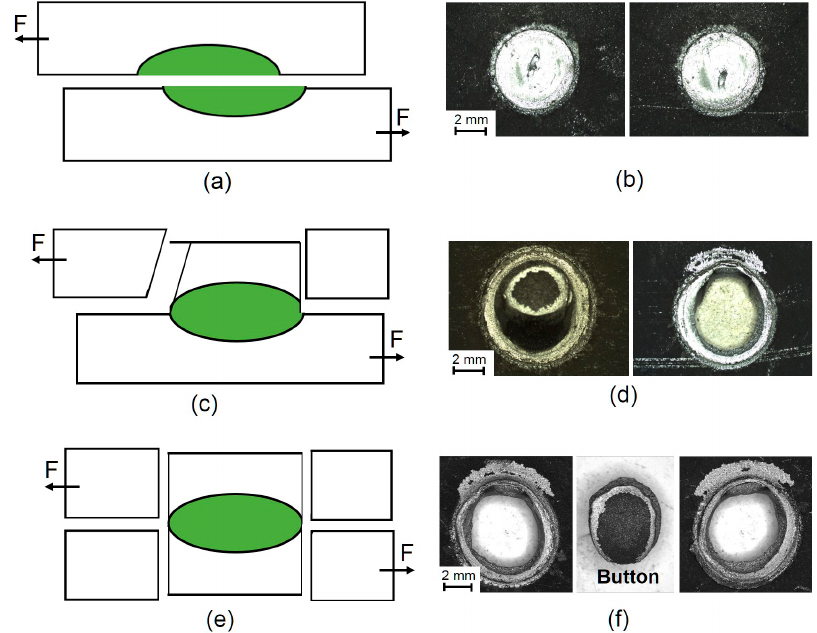
Figure 4. Typical fracture mode for welded B1500 joint: ( a ) schematic of IF; ( b ) failed IF joint; ( c ) schematic of PF I; ( d ) failed PF II joint; ( e ) schematic of PF II; ( f ) failed PF II joint.